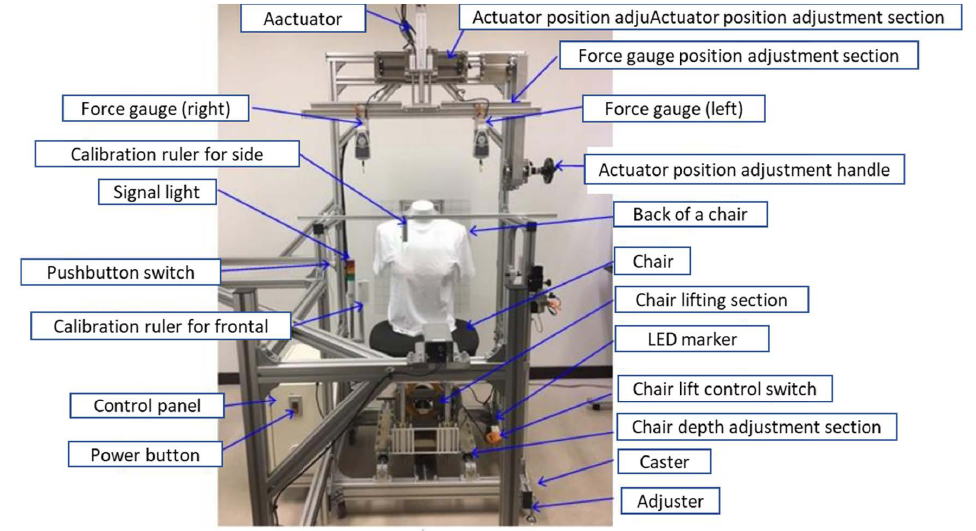
Figure 1. Overview of the breast droop value measuring device.